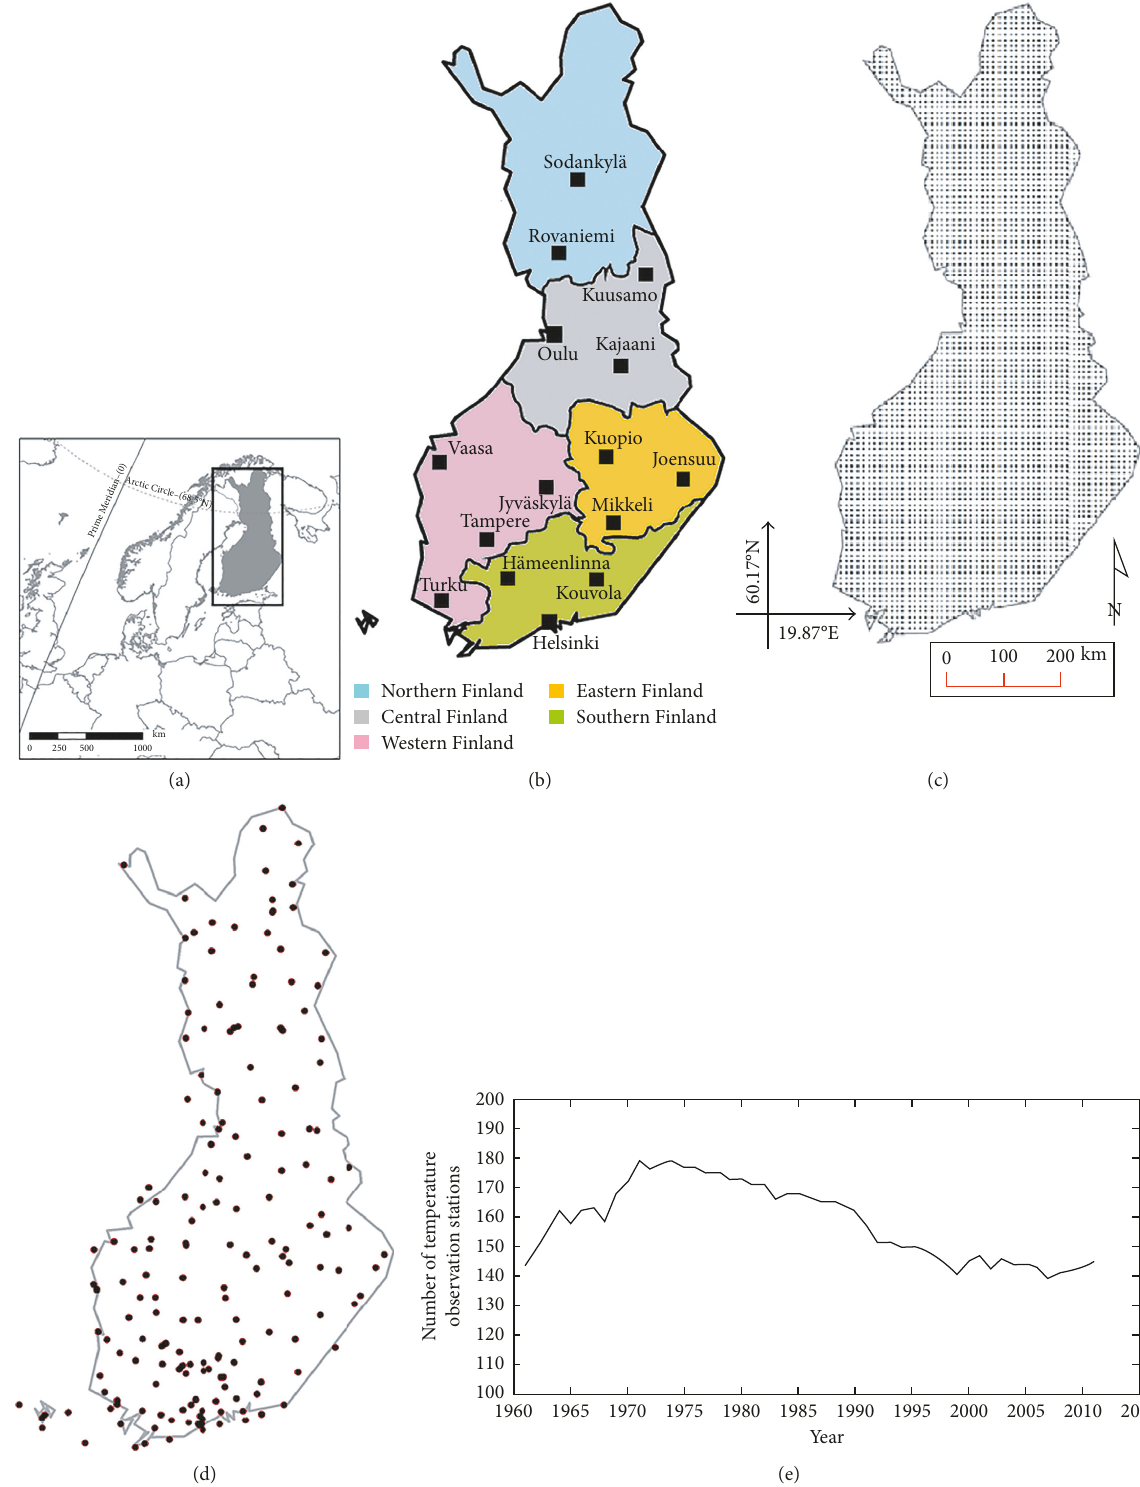
Figure 1: (a)Locationofthestudyarea,(b)differentregionsinFinland,(c)regular gridpoints(10 temperature datasets across Finland obtained from PaiTuli, (d) daily temperature measurement stations in Finland used for calculation of the gridded time series, and (e) temporal variability in the number of daily temperature measurement stations in Finland over